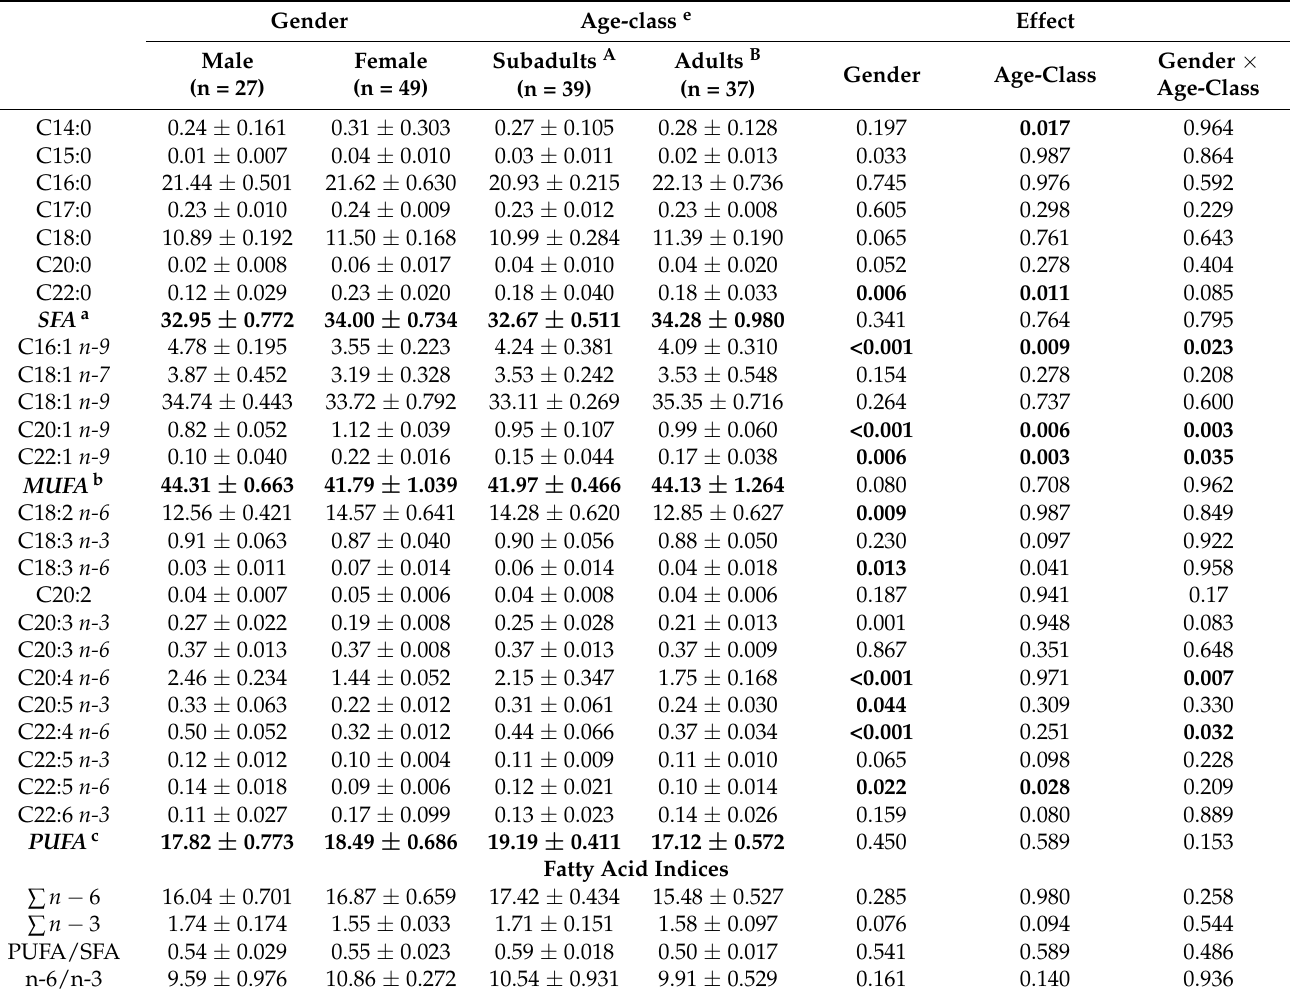
Table 4. Effect of gender and age-class on the fatty acid composition (% of total fatty acids, mean ± SEM) of M. Biceps femoris , corrected for carcass weight and muscle fat content